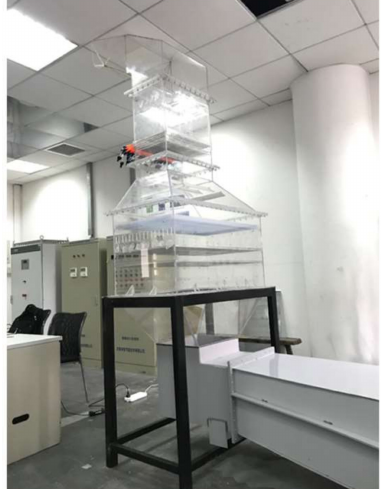
Figure 3. The platform of flow model test (FMT)